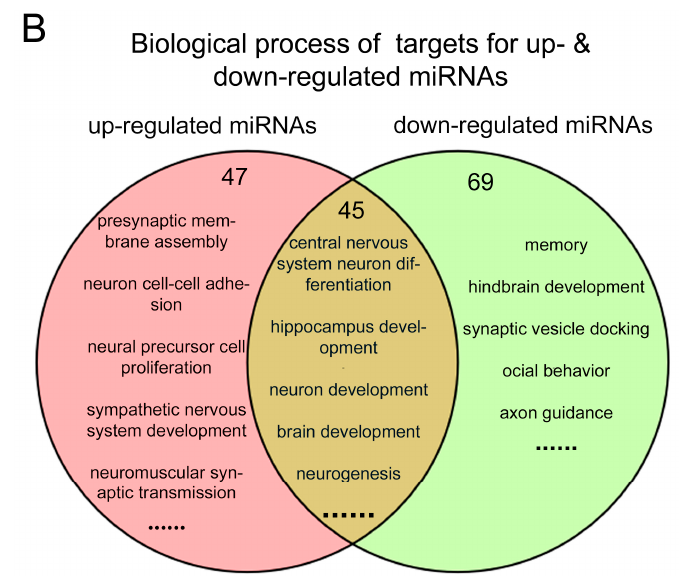
Figure 5. Venn diagrams of the comparison analysis of target genes for up- and down-regulated miRNAs. ( A ) Venn picture of GO analysis; ( B ) Venn picture of KEGG analysis. Jak-STAT: Janus kinase/signal transducers and activators of transcription; NOD: nucleotide binding oligomerization